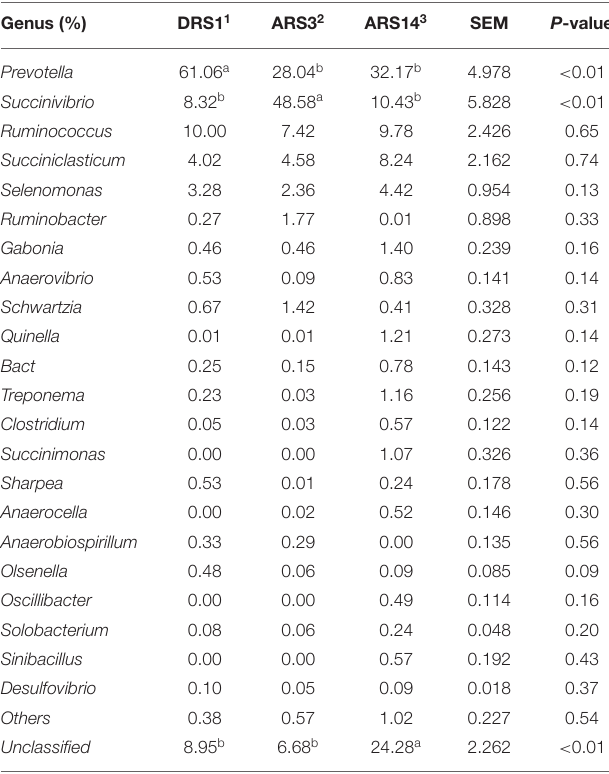
TABLE 4 | The composition of phylum-level microbes in rumen fluid after fistula surgery in sheep and their relative abundance. Phylum (%) DRS1 1 ARS3 2 ARS14 3 SEM P -value